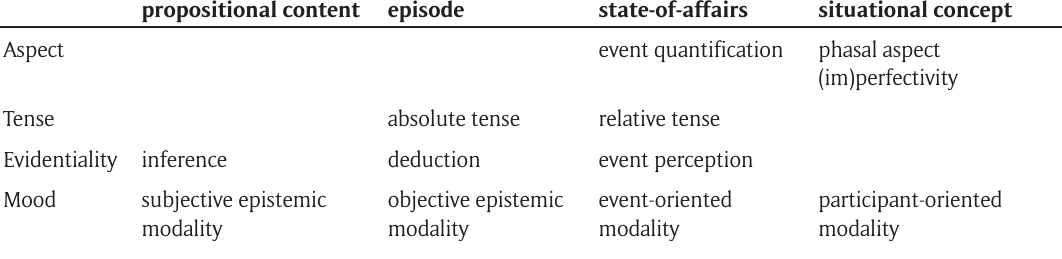
Table 1: TMAE categories in Functional Discourse